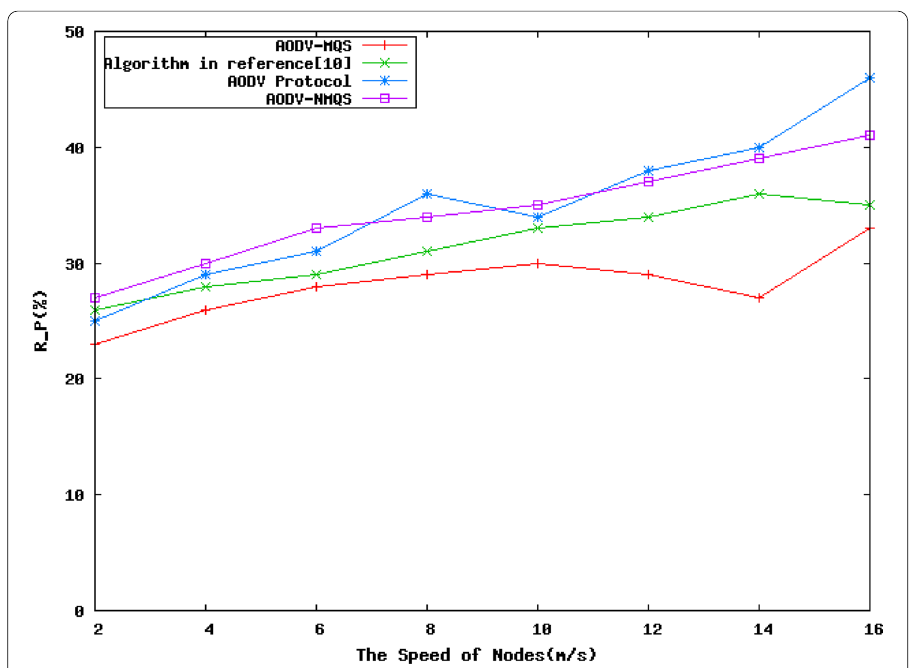
Fig. 11 Comparison of overhead of four routing algorithms in an unsafe